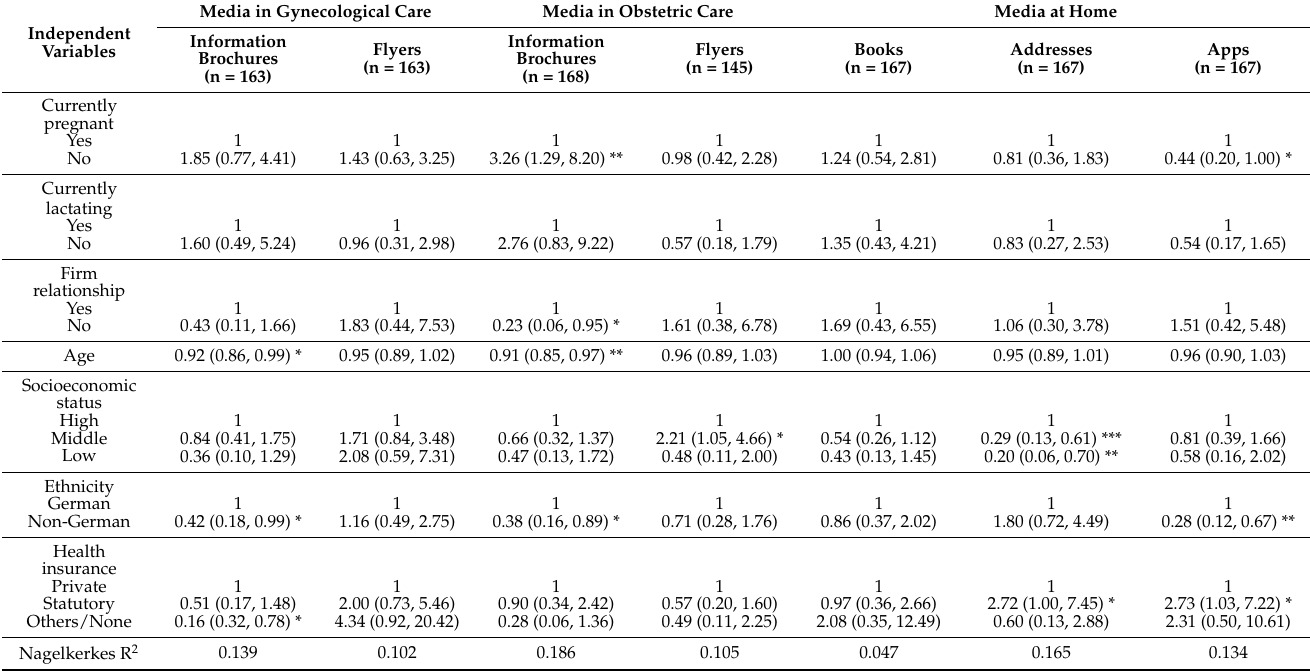
Table 3. Probability of preferring selected media formats on health-related behaviors during pregnancy and lactation in gynecological and obstetric care and for use at home in association with independent variables, expressed in odds ratios (95% confidence